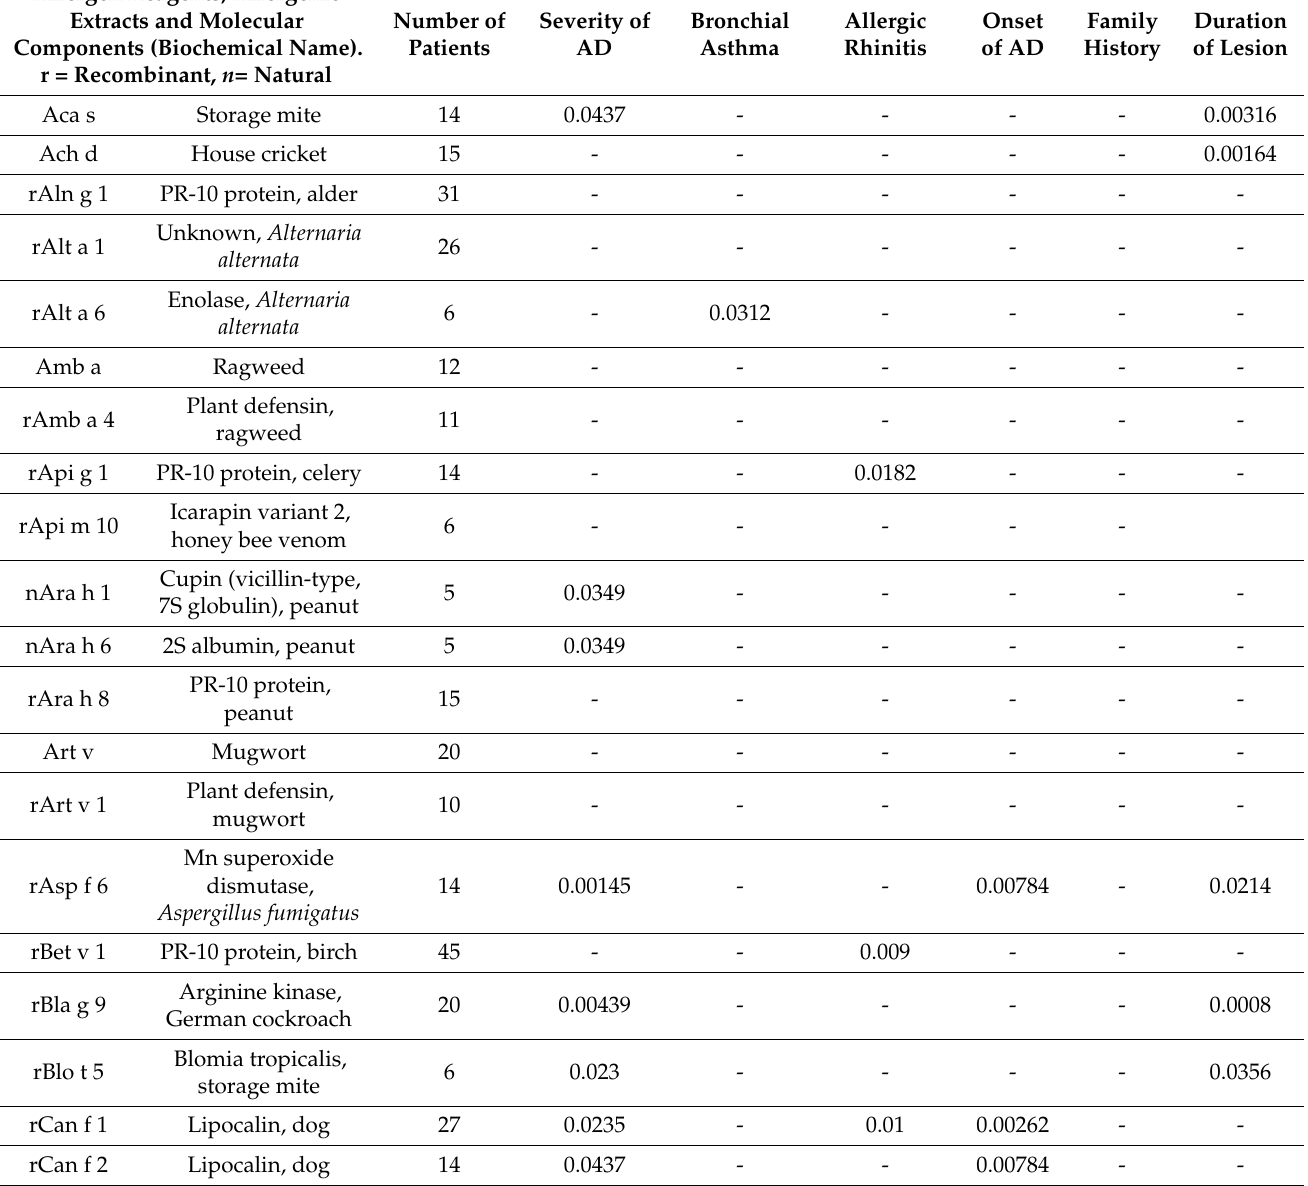
Table 4. Allergen reagents (molecular components) with the level of specific IgE in Classes 3 and 4 with the positivity in 5 and more patients (according to TURF—total unduplicated reach and frequency). The relation between the level of specific IgE in Classes 3 and 4 and the occurrence of bronchial asthma, allergic rhinitis, the severity of AD, the onset of AD (under 5 years of age or later), family history, and duration of eczematic lesions (persistent or occasional). The levels of significance ( p -value) are calculated in the chi-square test (at an expected minimum frequency of at least 5) or in Fisher’s exact test. We show only the significant relation ( p -value <